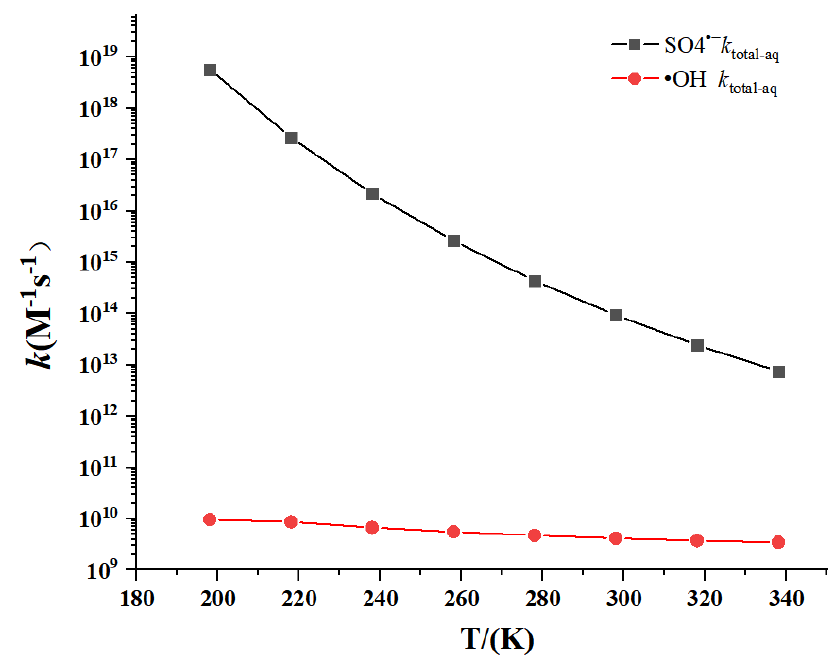
Figure 7. Temperature dependence of the calculated rate constants.